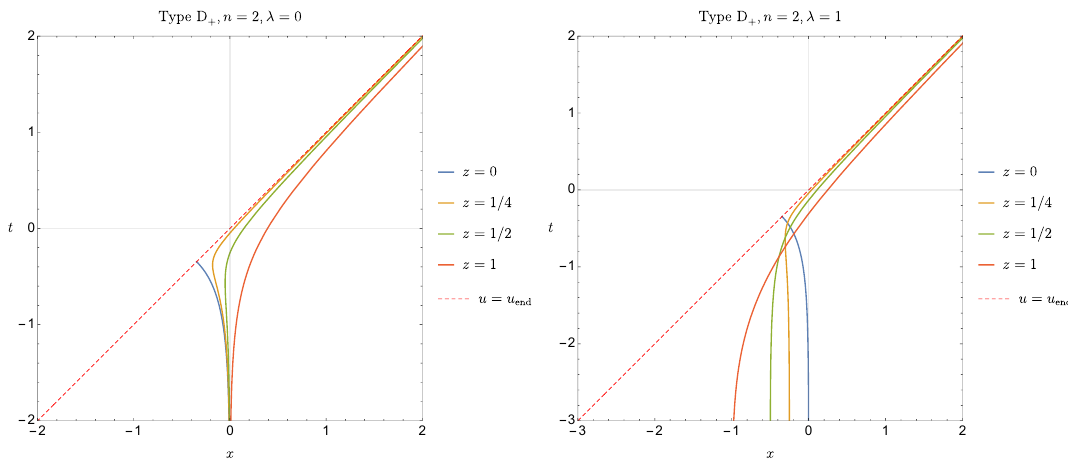
Figure 20 . Profiles of the brane Q associated with mirrors of type D + in coordinates ( t, x ) for various z . The mapping functions are given in eq. (4.26). Here, we have chosen β = 1 for both